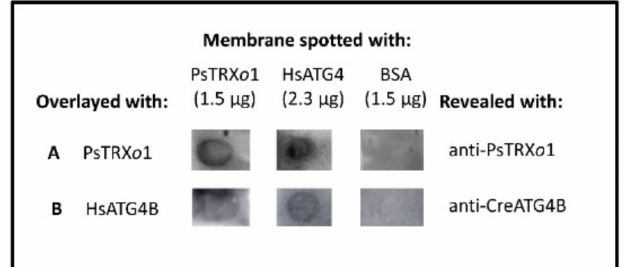
Figure 10. Representative protein gel dot blot analysis of the interaction between recombinant PsTRX o 1 and HsATG4. Membranes were spotted with recombinant PsTRX o 1, HsATG4B, and BSA (negative control) and were overlayed with TBST buffer containing the recombinant PsTRX o 1 or HsATG4B proteins. The presence of the proteins was revealed using anti-PsTRX o 1 or anti-CreATG4B antibodies,